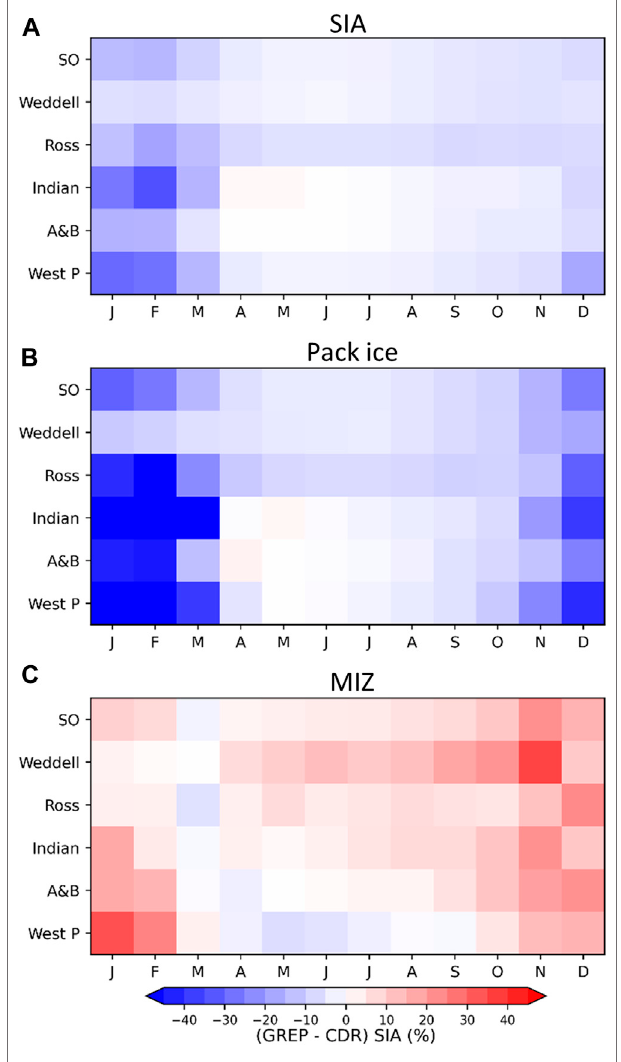
FIGURE 7 | Seasonal cycle of (GREP minus CDR, in %) monthly climatologyof (A) totalice(upperpanel), (B) packice(middle)and (C) MIZarea in the Southern Ocean and its fi ve sectors. Differences are shown as a percentage of CDR values computed for the years 1993 – 2019. Red (blue) indicates that GREP reproduces higher (lower) SIA compared to